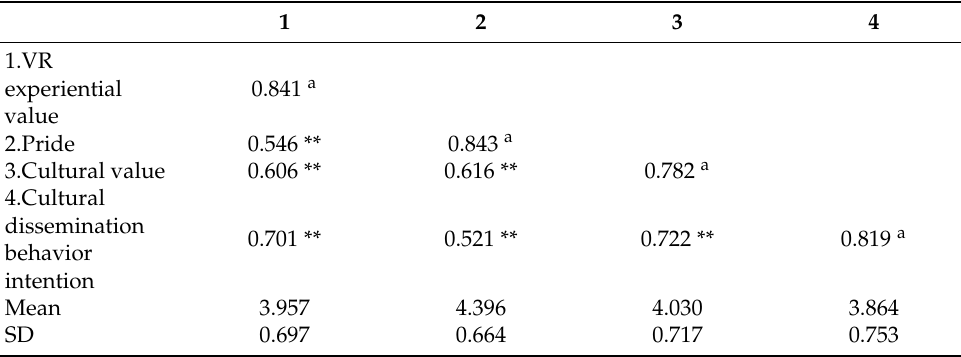
Table 4. Means, standard deviations, and correlations of the